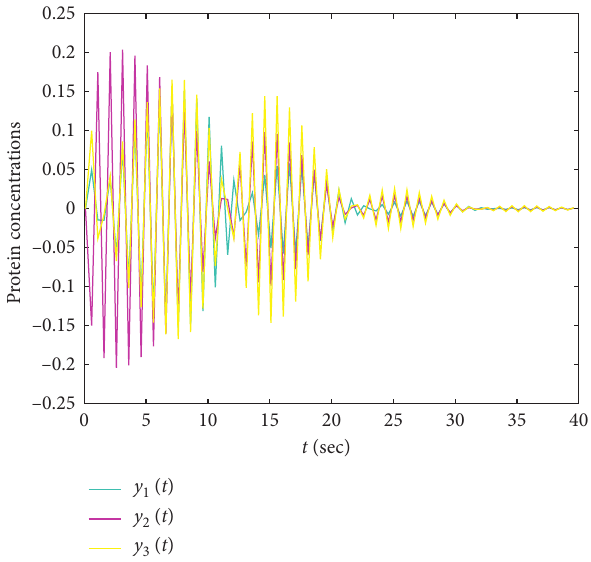
Figure 2: Protein concentrations y ( t ) in Example 2. Table 1: The maximum allowable time delay upper bound for τ